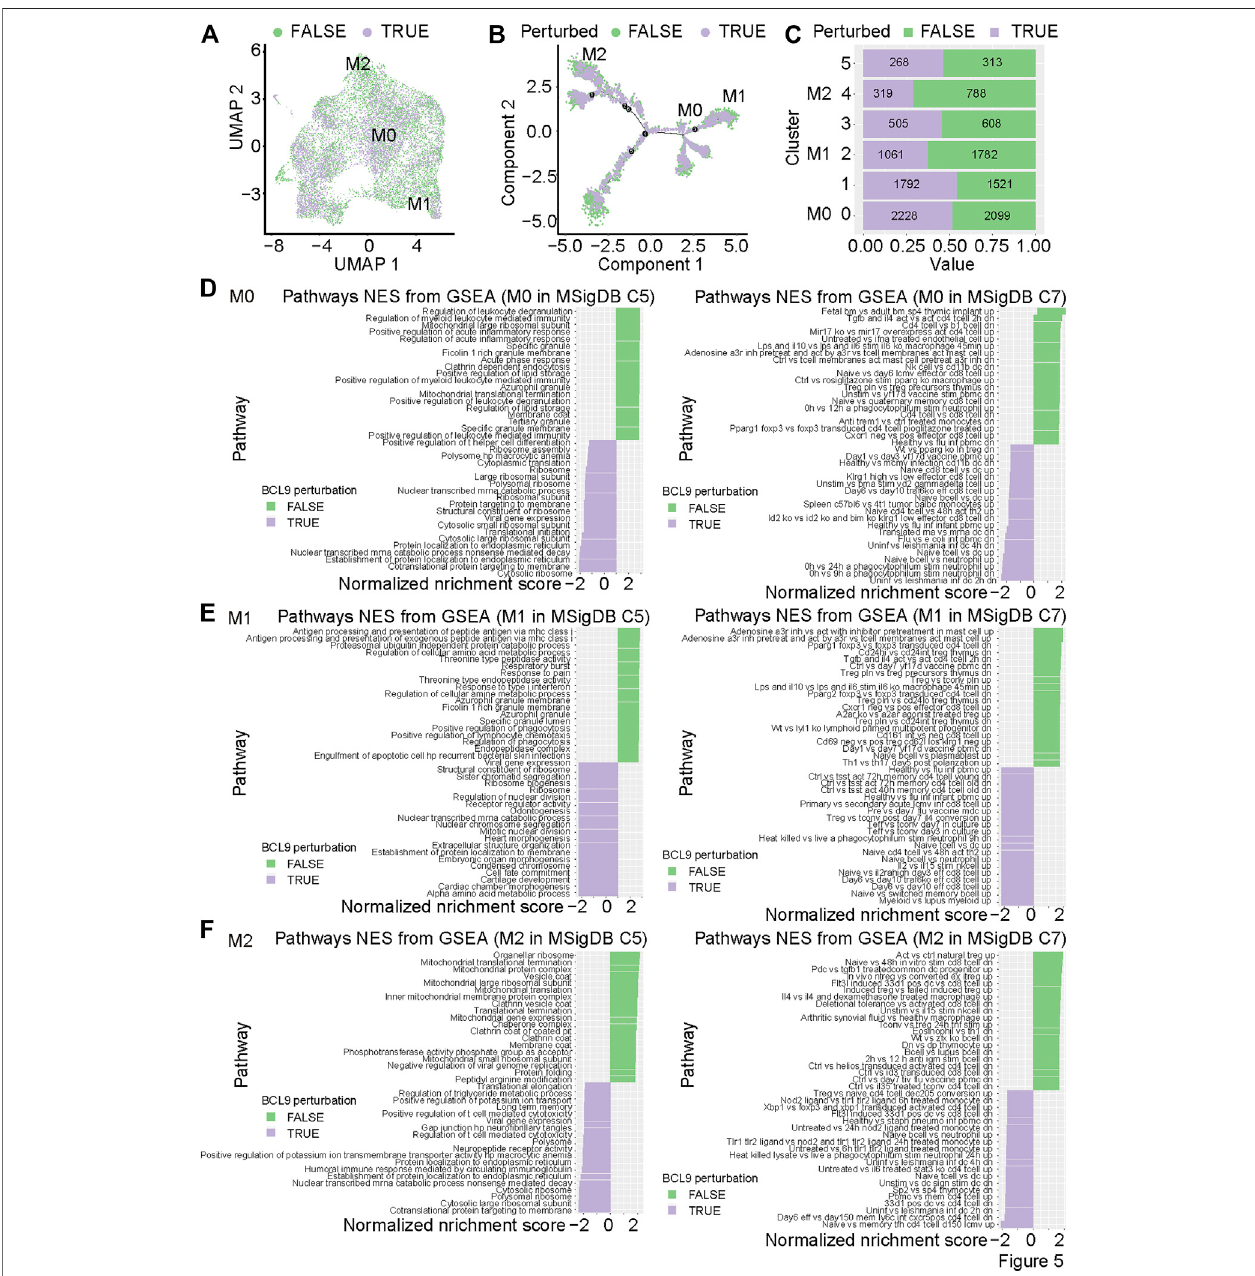
FIGURE 5 | The perturbation of Bcl9 inhibits the differentiation and function of M0, M1 and M2 in CT26 tumor. (A) UMAP mapping of TAM ( Figure 3A ) and perturbationof Bcl9 ornot; (B) trajectoryofM0,M1andM2( Figure4A )andperturbationof Bcl9 ornot; (C) Barchartofcellproportionsfromperturbationof Bcl9 inTAM clusters,thenumberistheactualnumberofcells.GSEAanalysisforM0 (D) ;M1 (E) ,andM2 (F) TAMcells,MsigDBC5(AllgenesetsderivedfromGeneOntology)isused on the left, and MsigDB C7 (immunologic signature gene sets) is used on the right.